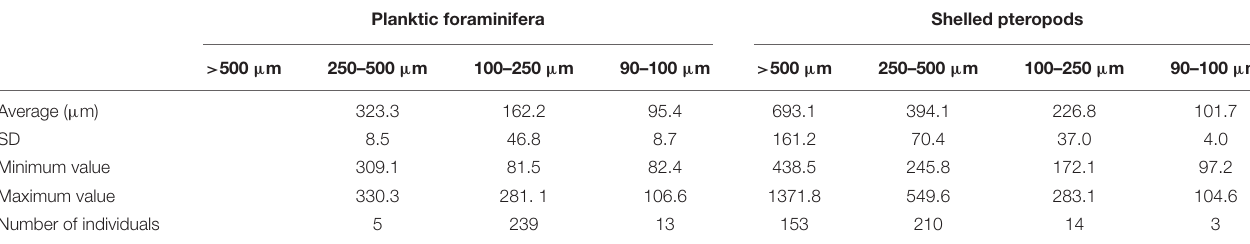
TABLE 2 | Average size, SD, minimum and maximum value and number of individuals measured. Planktic foraminifera Shelled